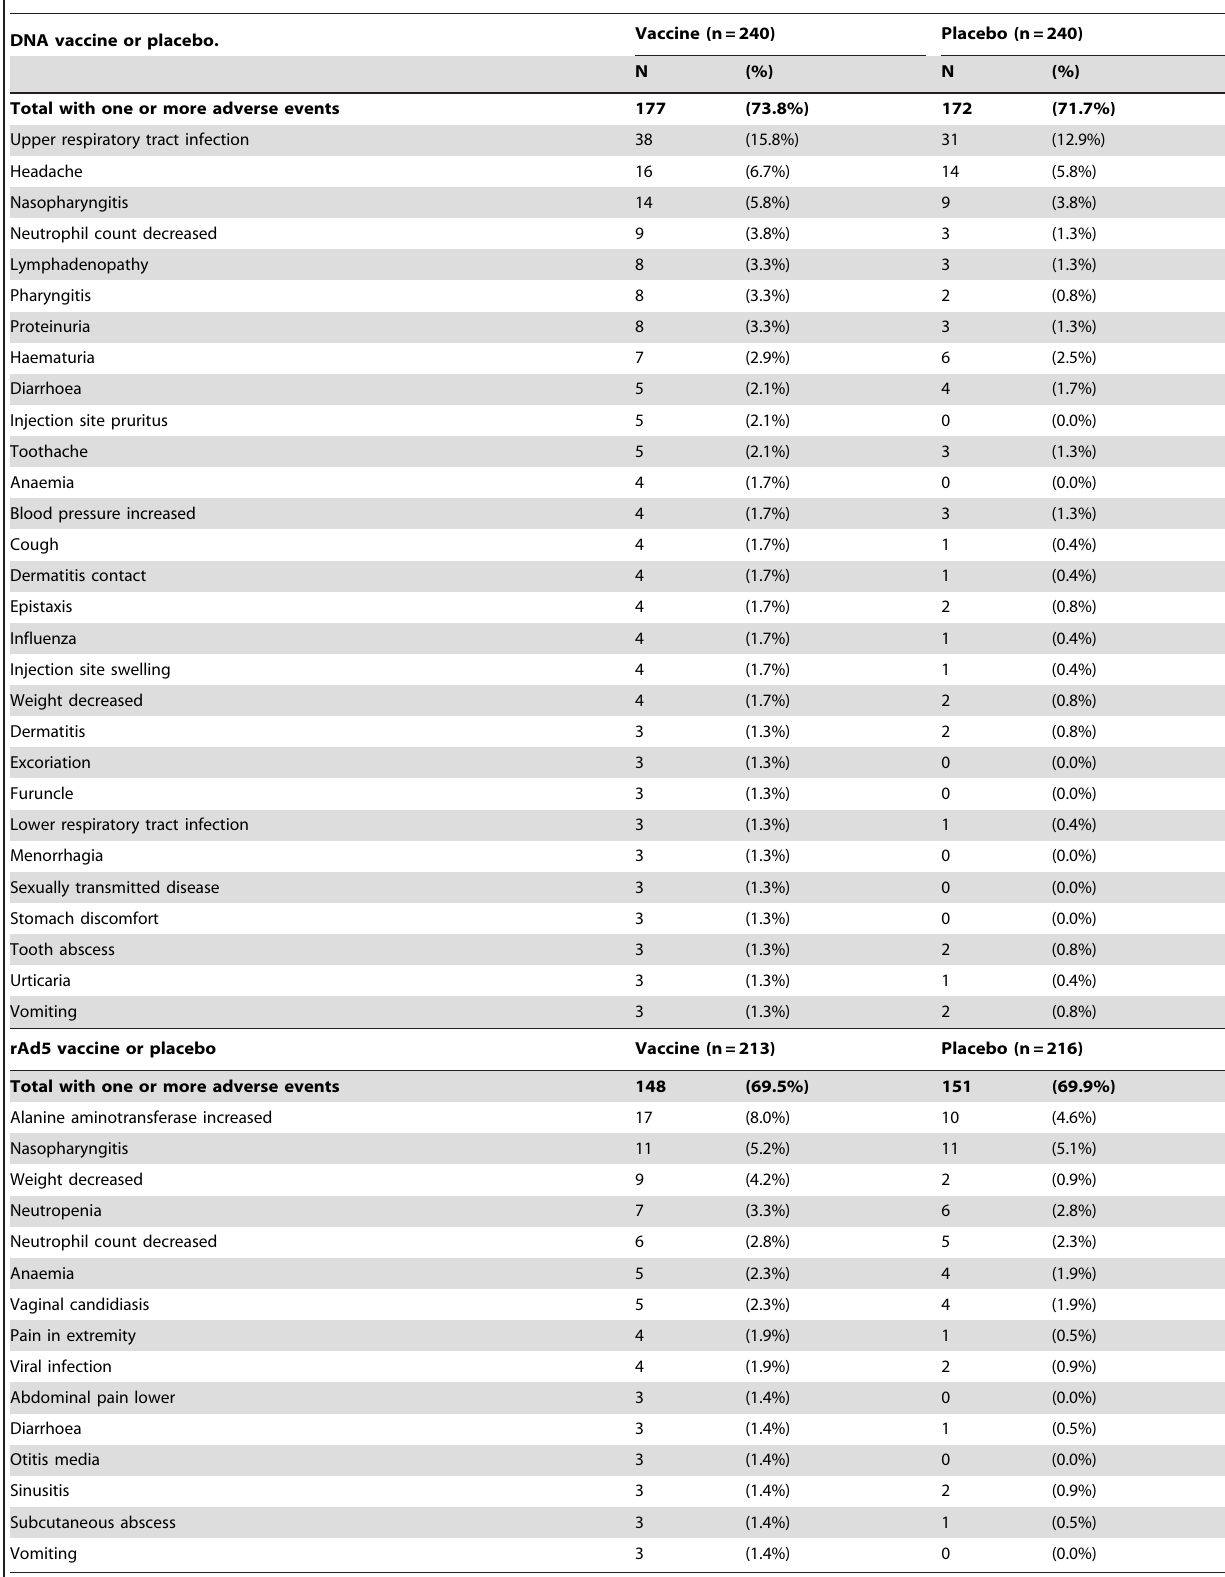
Table 2. Adverse events occurring more frequently in vaccine participants.